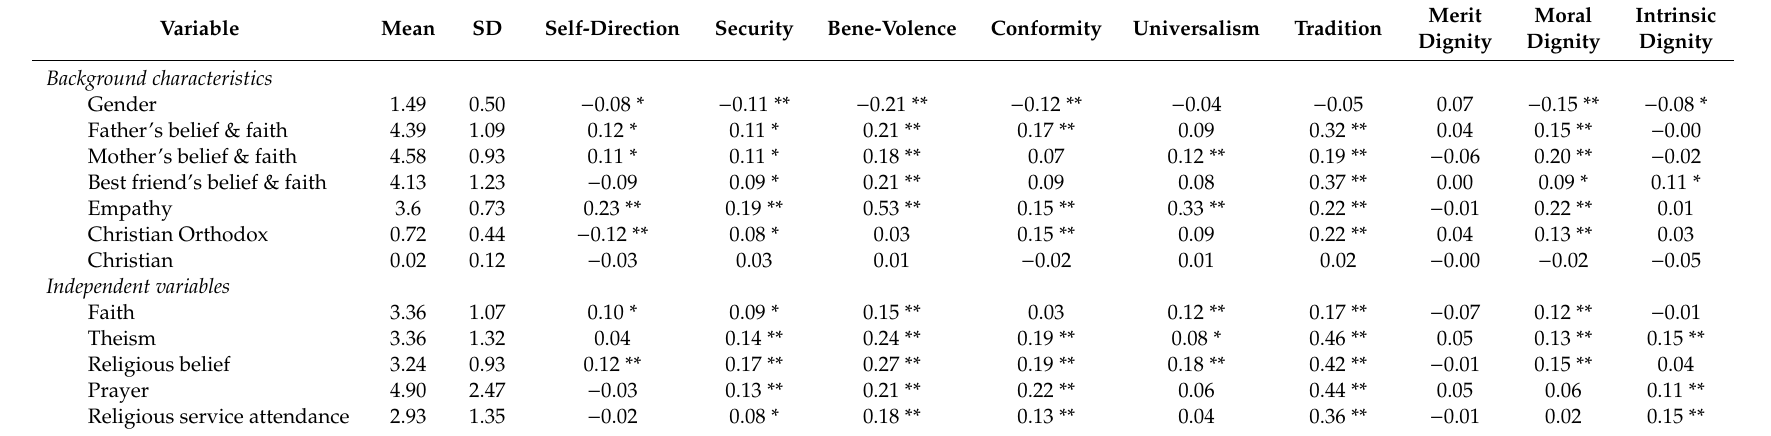
Table 1. Correlations (Pearson’s r) between faith, theism, religious belief, prayer, religious service attendance, individual values, human dignity, and background variables. Variable Self-Direction Background characteristics